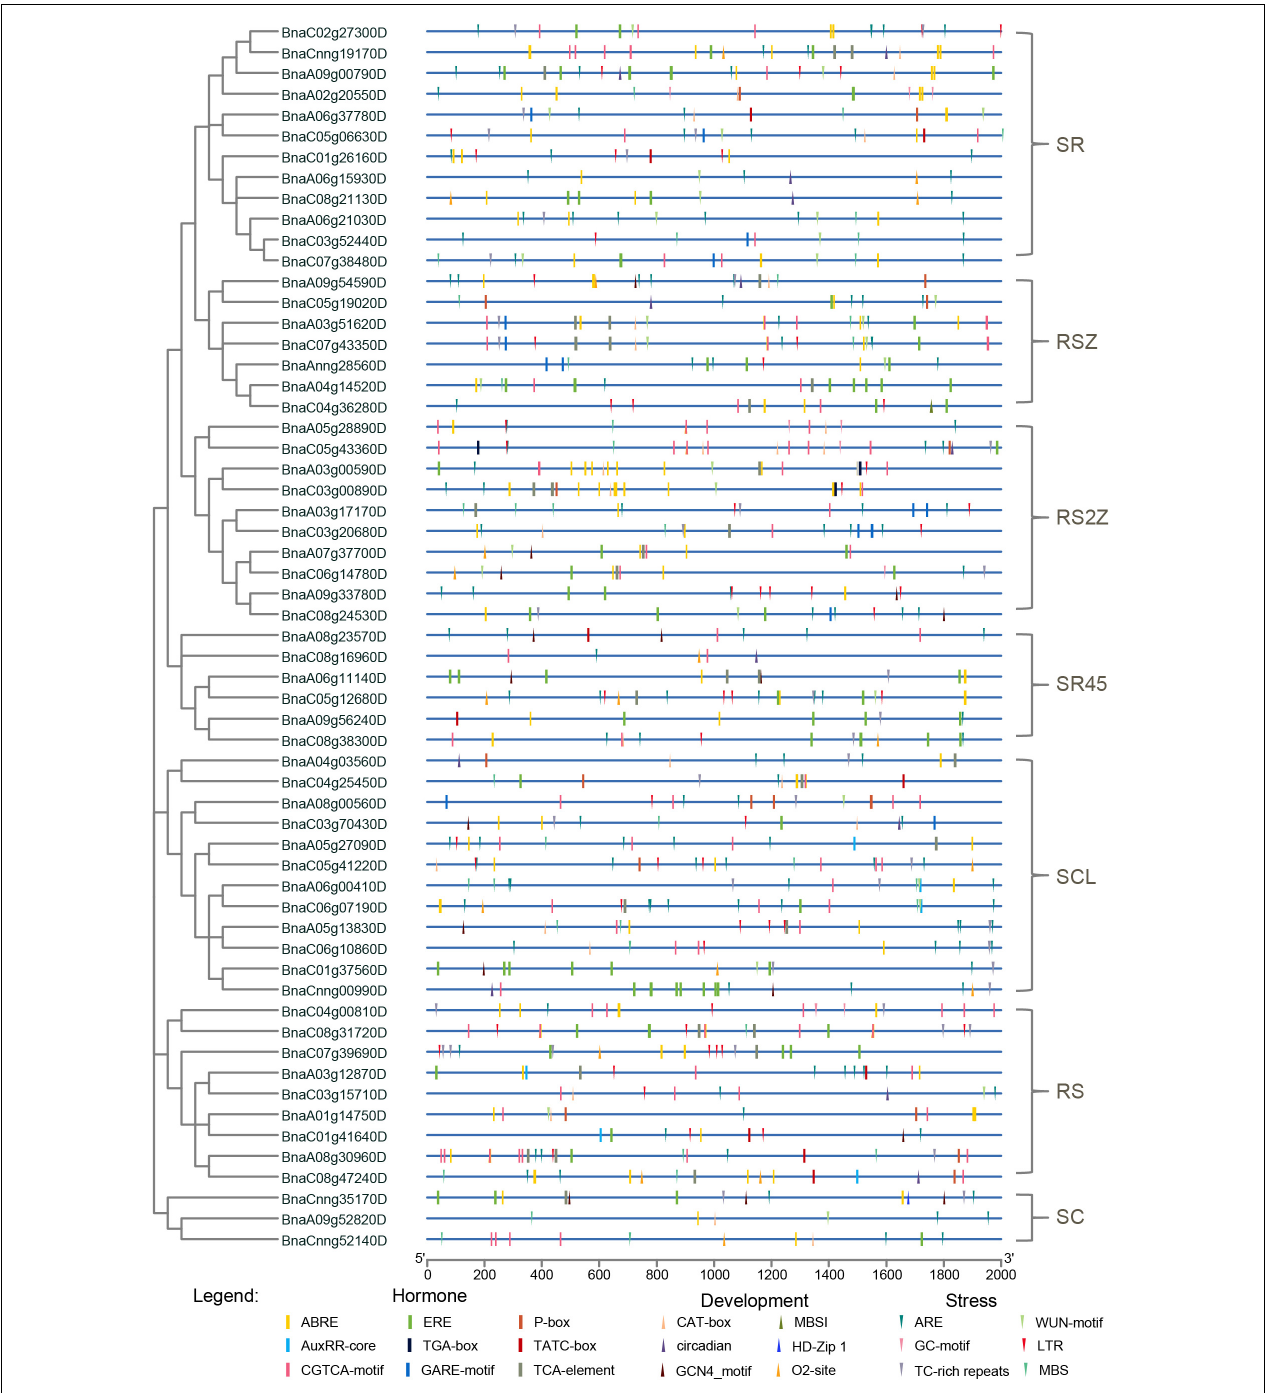
FIGURE 4 | Cis -acting regulatory elements identified in promoters of SR genes in B. napus . Boxes indicated hormone-related elements, up-triangles indicated development-related elements, and down-triangles indicated stress-related elements. Different colors indicated different